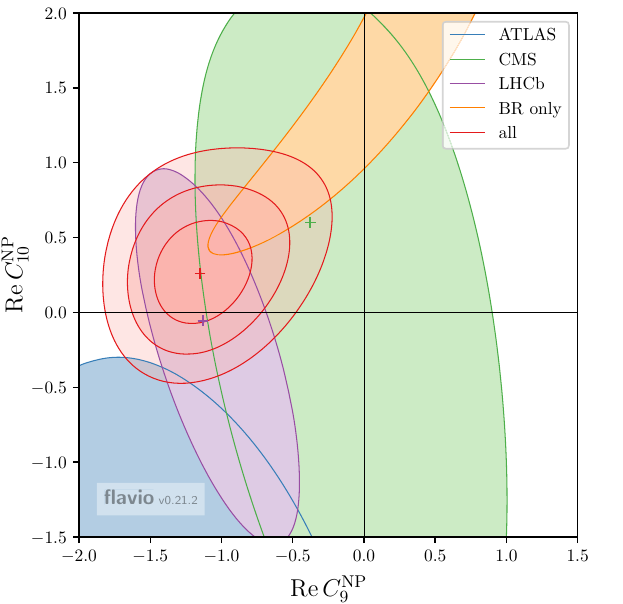
observables from individual experiments as well as for the constraints from branching ratio measurements of all experiments (“BR only”), we show the 1 σ ( (cid:11)χ 2 ≈ 2 . 3) contours, while for the global fit (“all”), we show the 1, 2, and 3 σ